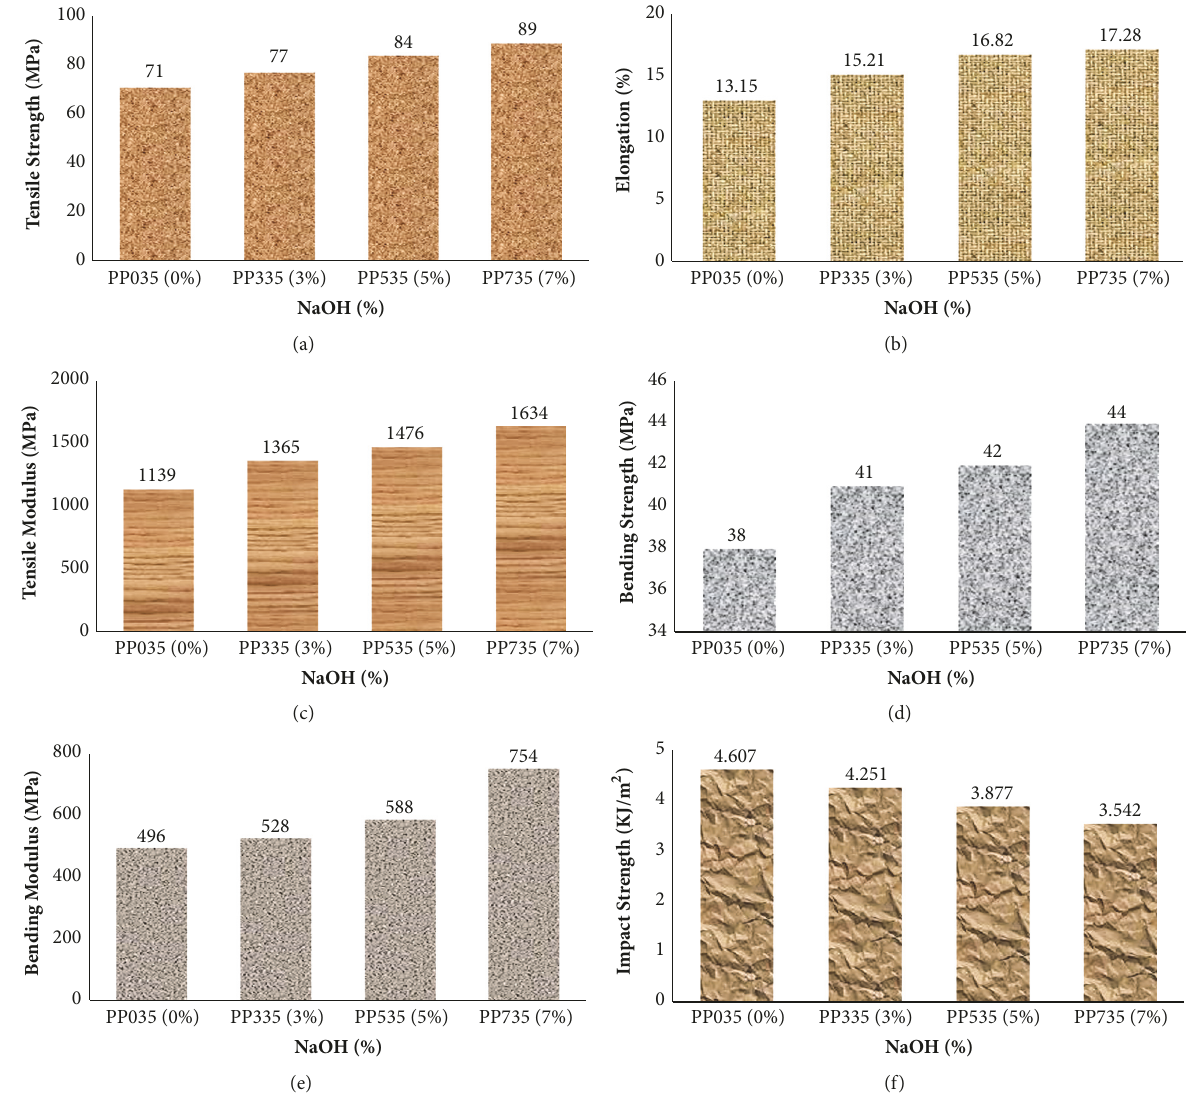
Figure 3: Effect of alkali treatment on the mechanical properties of PALF/PP